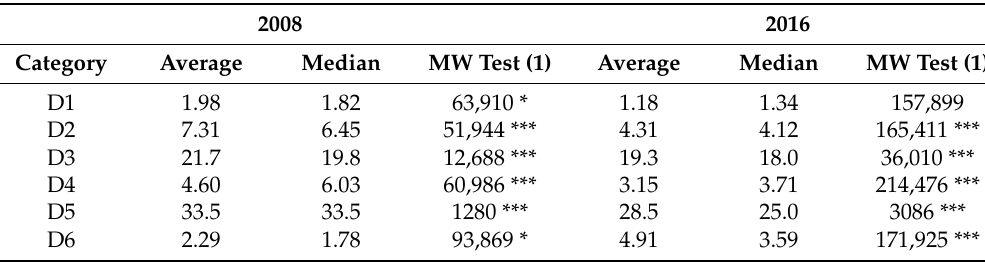
Table 4. Summarizes the central trend of the di ff erence in values in percentage points (p.p.) by dimension in 2008 and